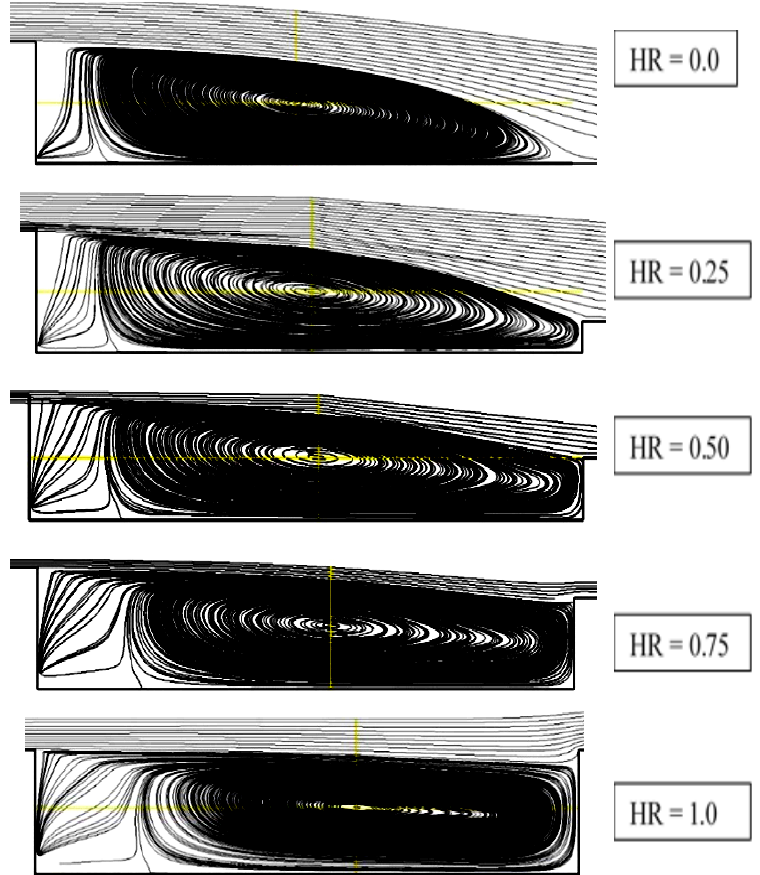
Figure 6. Streamlines inside the shallow cavity with (AR = 5.0) at different height ratios (0.0 ≤ HR ≤ 1.0).